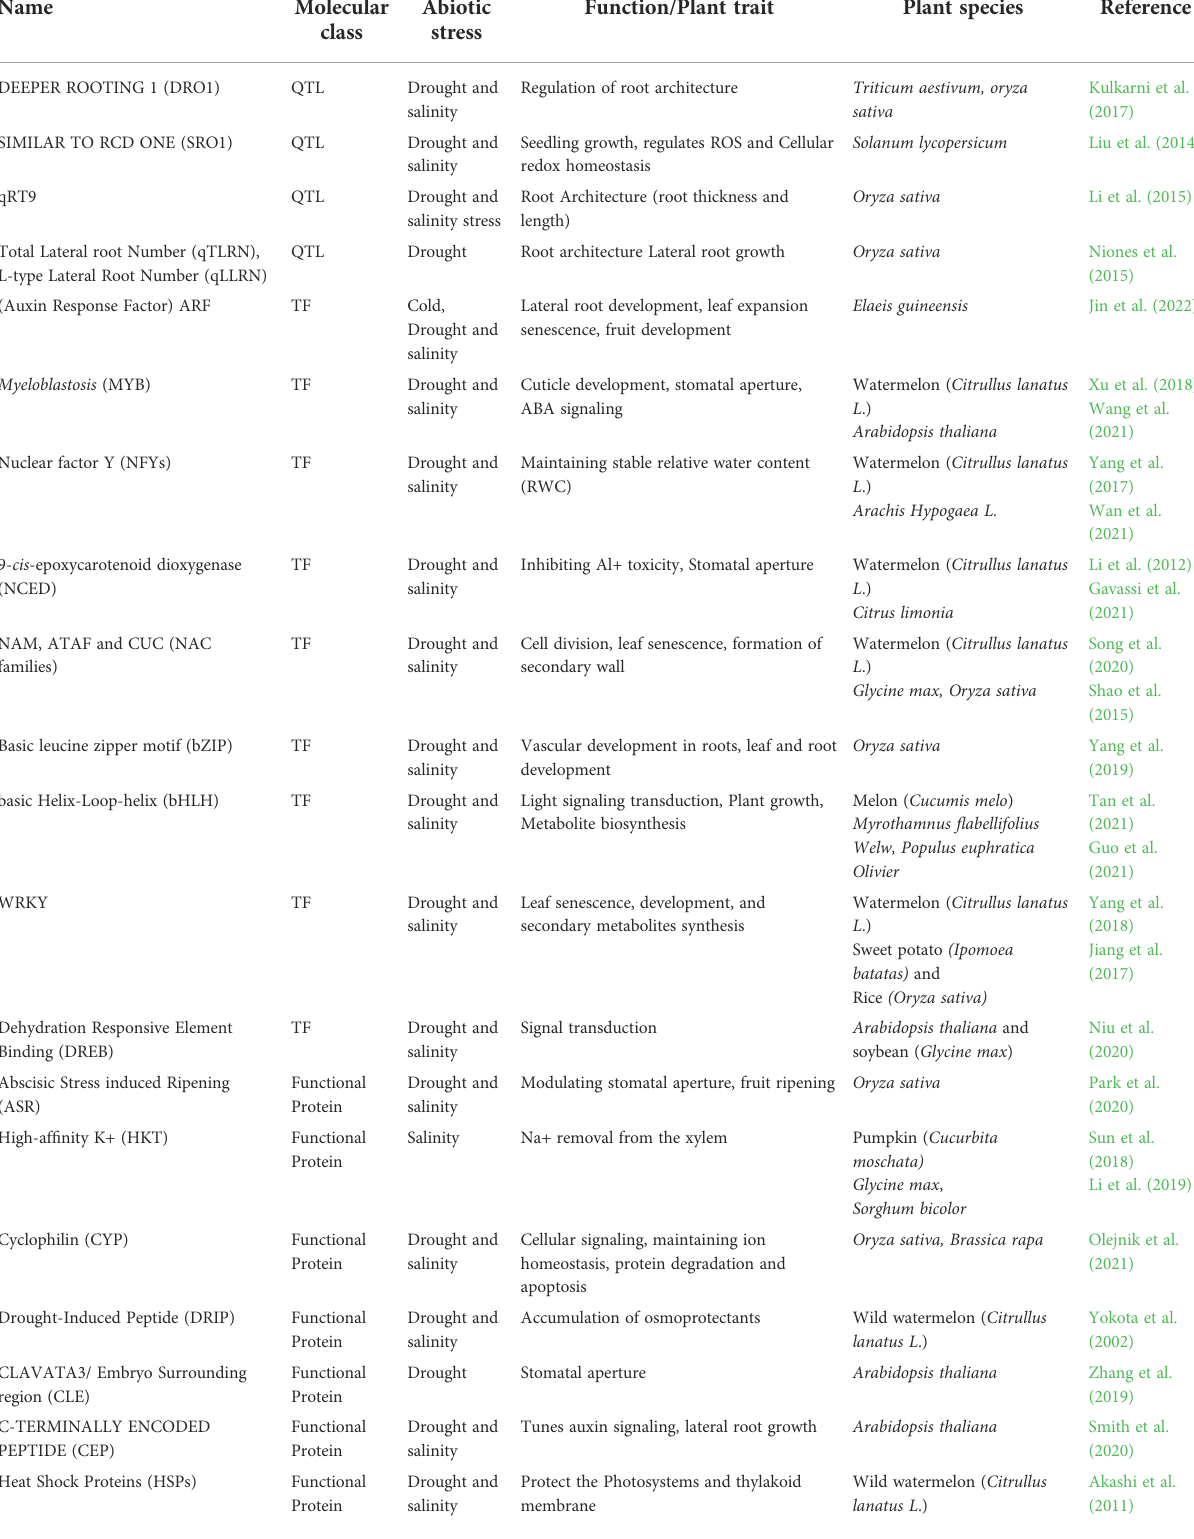
TABLE 1 Molecular mechanisms involved in plant tolerance against salinity and drought